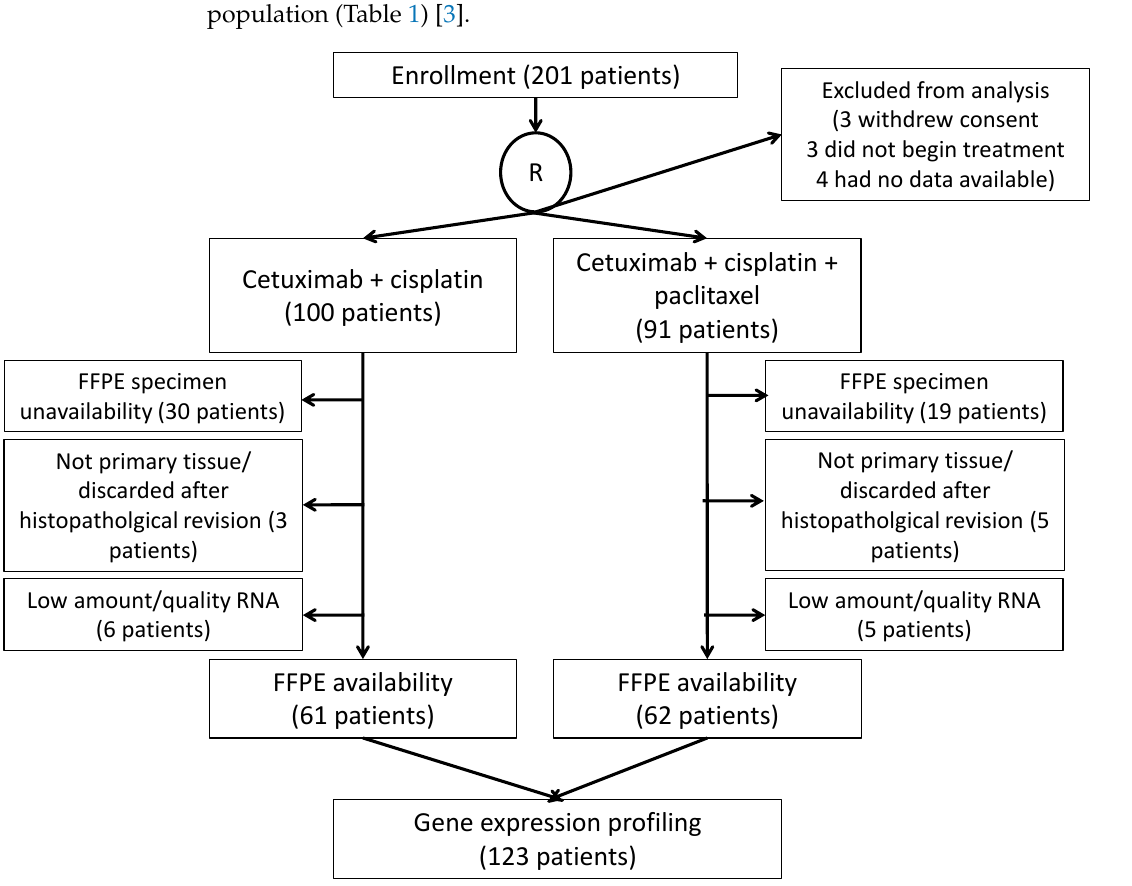
Figure 1. CONSORT